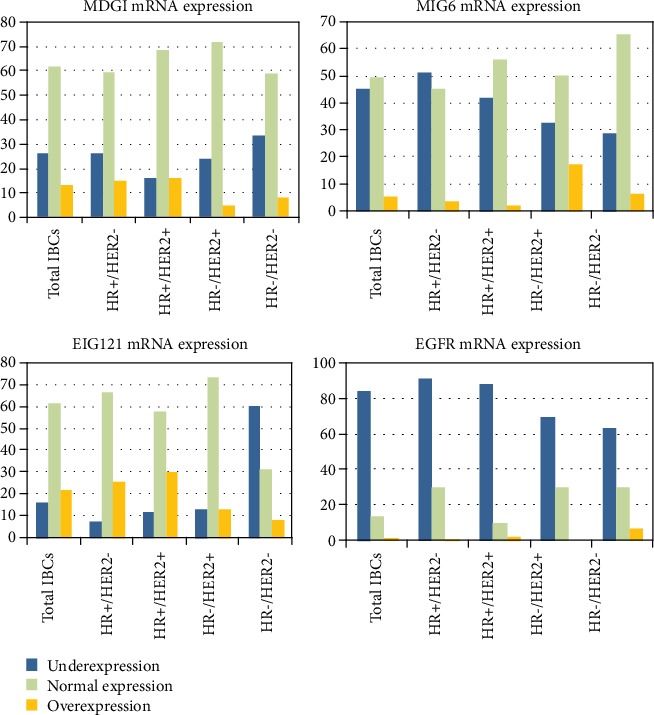
Results obtained by RT-PCR showed that MIG6 is mainly underexpressed in invasive breast carcinomas and more particularly in the HR+/HER2- subtype. Both overexpression and underexpression were observed for the two other genes: MDGI and EIG121 are mainly overexpressed in the two HR+ subtypes. TNCs showed high frequency of EIG121 underexpression.